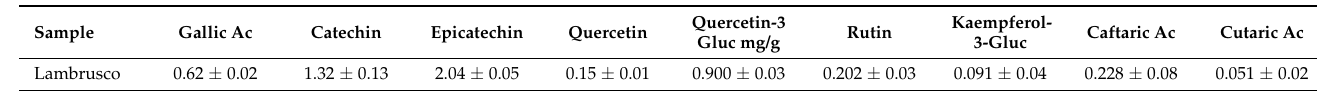
Table 1. Characterization of the phenolic profile of a lyophilized water extract of total Lambrusco pomace.